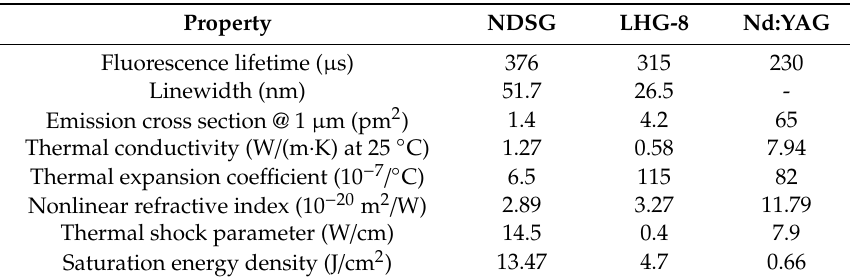
Table 1. Physical parameters of three gain materials.